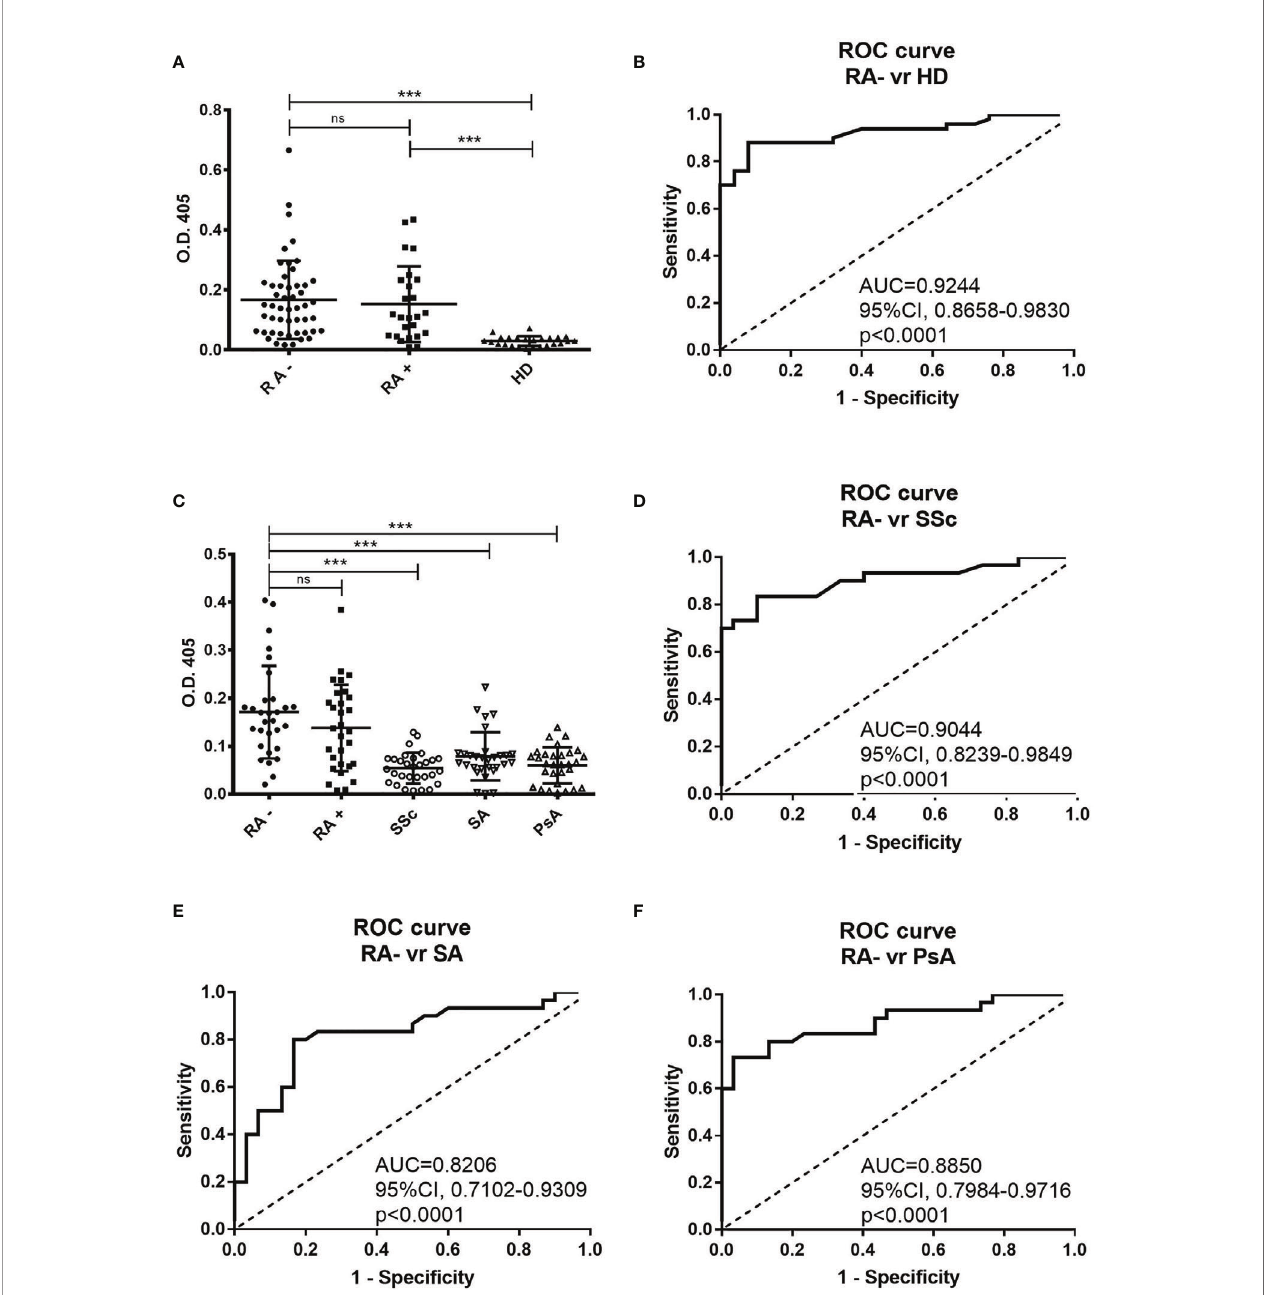
FIGURE 1 | Direct binding of individual patients ’ and healthy donors ’ sera to RA-peptide obtained from peptide library screening. (A) RA - peptide is recognized by serum IgG antibodies of seronegative RA patients ( ● ), by serum IgG of seropositive RA patients ( ■ ), but not by serum IgG of healthy donors ( ▲ ). The results are expressed as absorbance (O.D.) at 405 nm. Results shown are the mean values of three independent experiments. Bar line represents the mean absorbance value and standard deviation for each group. The differences among the different groups of patients and the healthy donors were determined by non-parametric Mann- Whitney test. Statistical signi fi cance is de fi ned as following: ***P < 0,0001, ns, not signi fi cant. (B) Receiver operating characteristic (ROC) analysis of O.D. value of serum from seronegative RA patients and healthy donors. AUC= area under the curve. (C) Binding of RA-peptide by serum IgG antibodies of the validation cohort of seronegative RA ( ● ), seropositive RA ( ■ ), and of patients with SSc ( ○ ), with SA ( ▽ ) and with PsA ( △ ). The results are expressed as absorbance (O.D.) at 405 nm. Lines indicate the mean absorbance value and standard deviation for each group. The non-parametric Mann-Whitney test was used to compare the different groups. ***P < 0,0001, ns, not signi fi cant. (D – F) Receiver operating characteristic (ROC) analysis of O.D. value of serum from seronegative RA patients and SSc or SA or PsA patients, respectively. RA, Rheumatoid arthritis; SSc, Systemic sclerosis; SA, Spondyloarthritis; PsA, Psoriatic